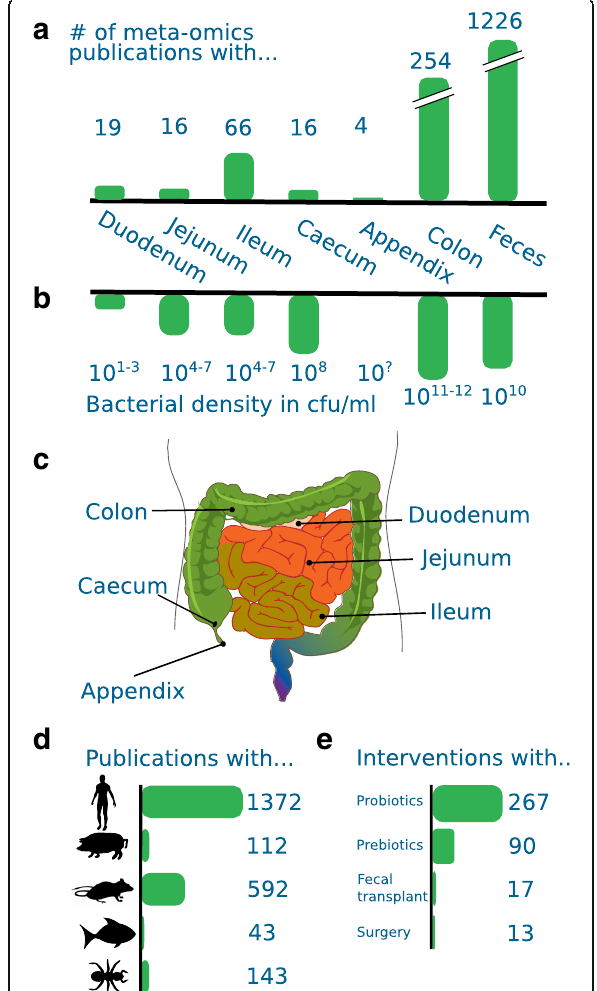
Fig. 1 The gut in the focus of meta-omics science. An overview of a main sampling sites and b microbial complexity is given, together with c an overview over the physiology. d The number of the studied hosts and e methods to improve gut health are indicated. All data was retrieved via PubMed searches for the corresponding terms. For the exact search terms, please see Additional file